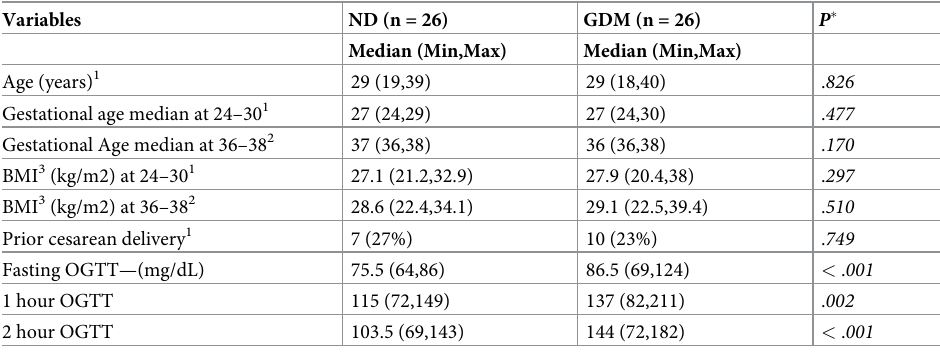
Table 1. Baseline characteristics of ND and DMG group. Variables